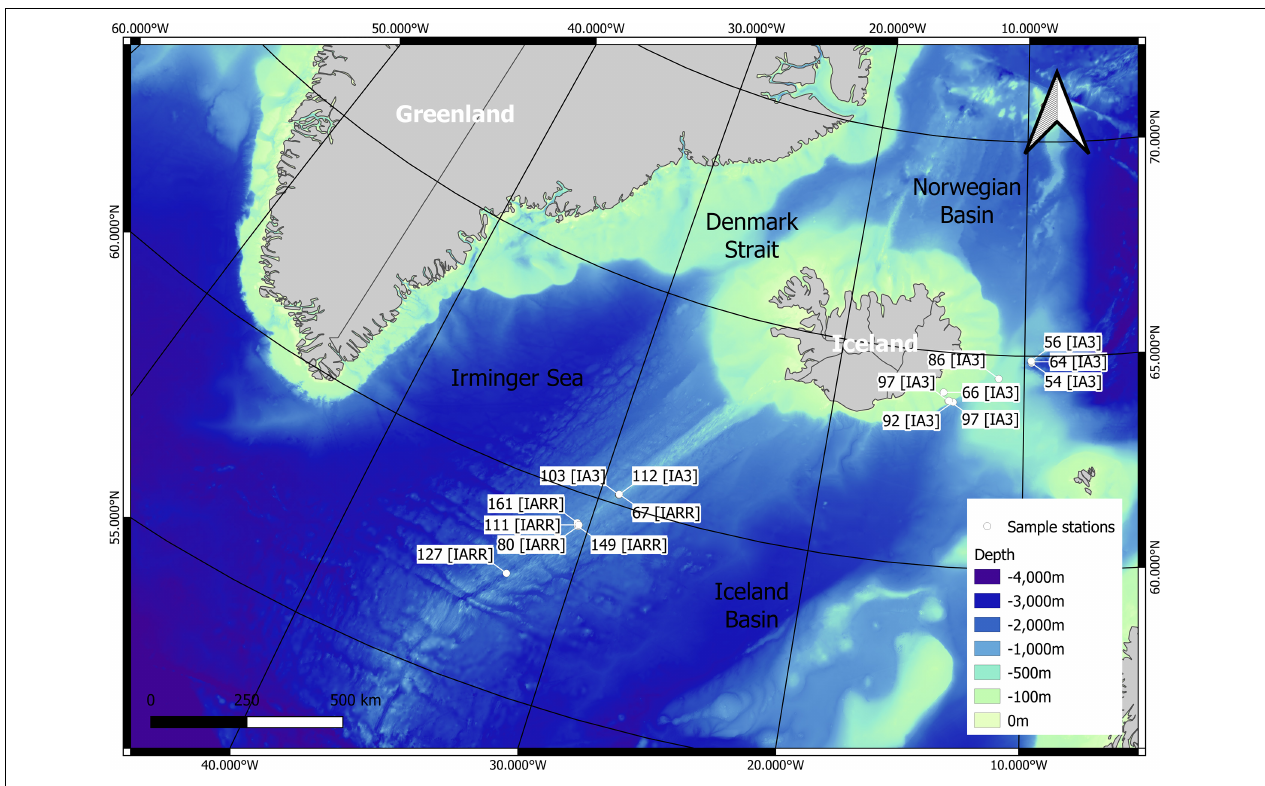
FIGURE 1 | Map showing the stations of the sampled specimens from research cruise IceAGE 3 (IA3) and IceAGE RR (IARR).